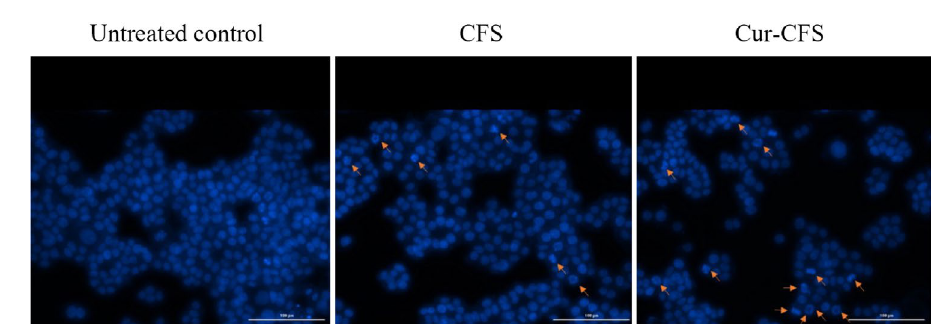
Figure 6. Chromatin changes in HT-29 colon cells after 24 h of treatment with metabolites of intact L. plantarum (CFS) and curcumin-treated L. plantarum